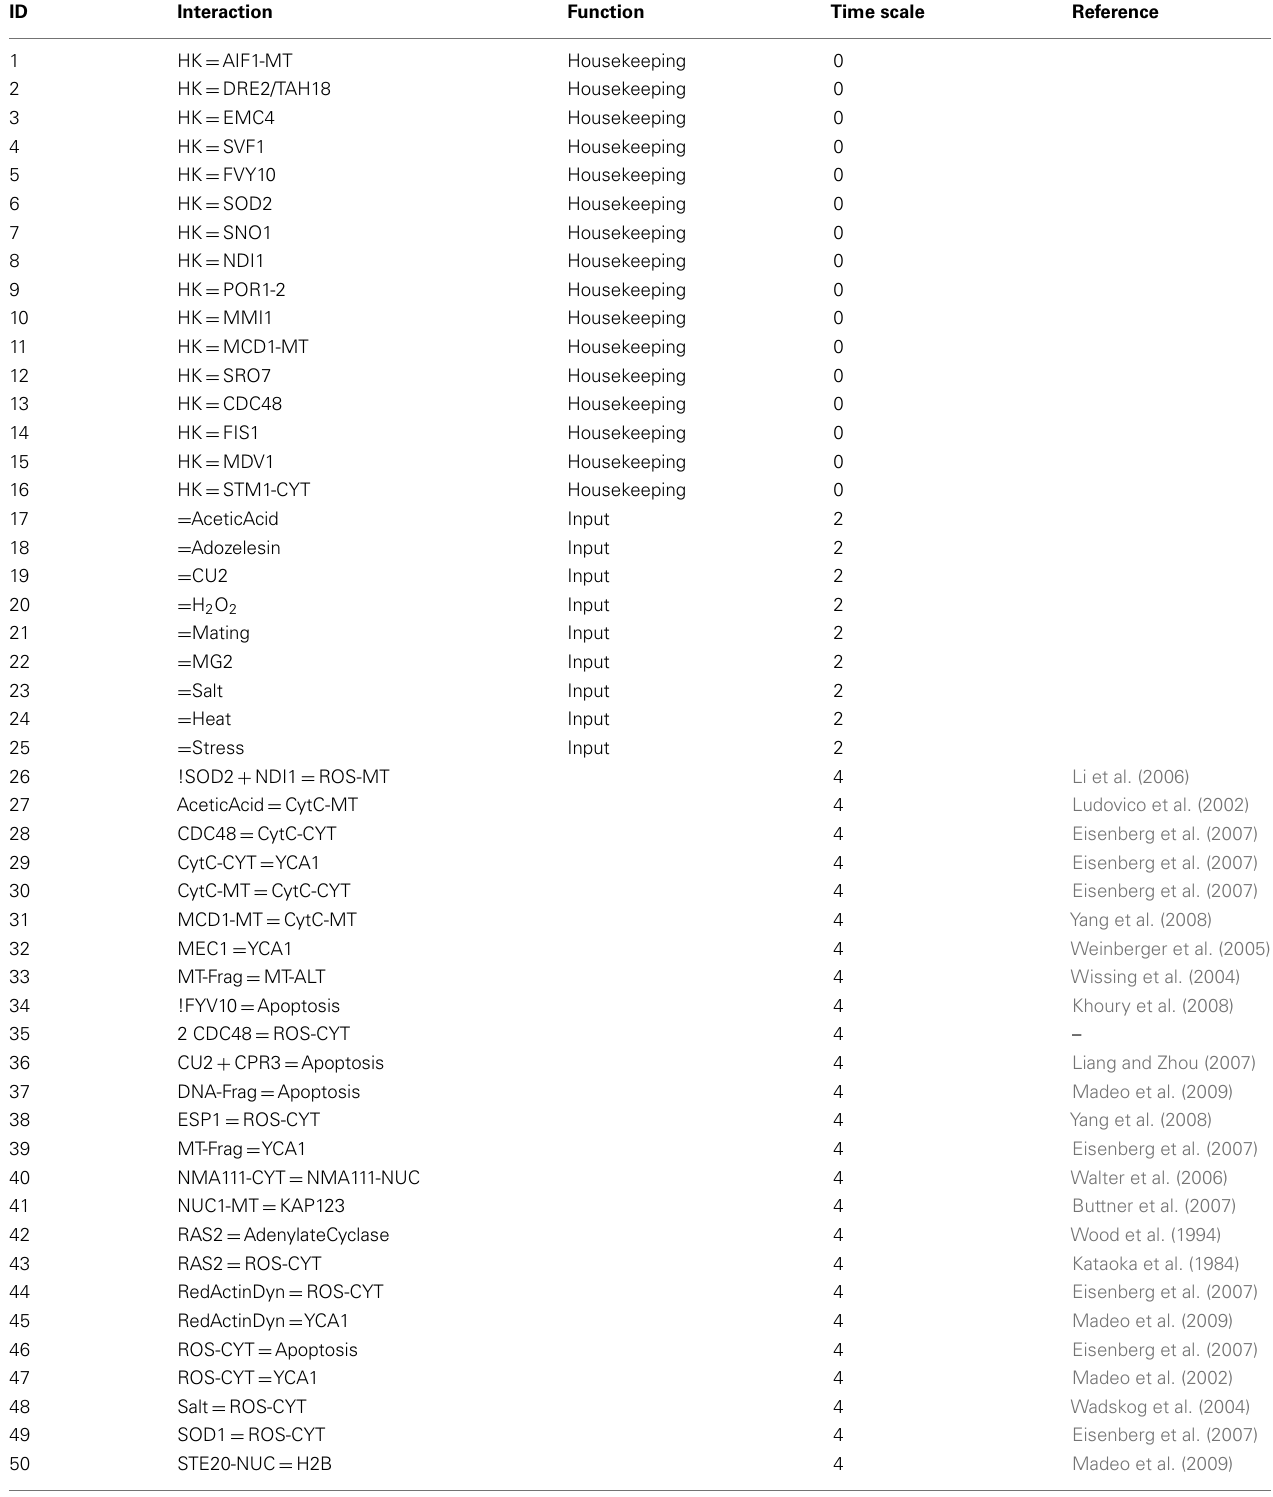
Table 3 | List of logical interactions in yeast Boolean